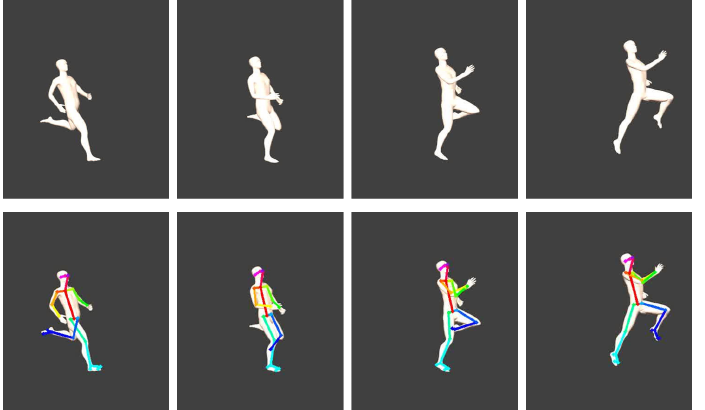
Figure 6. Single frames of one synthesised video of a long jump trial ( top ) with estimated OpenPose outputs from the synthesised video views ( bottom